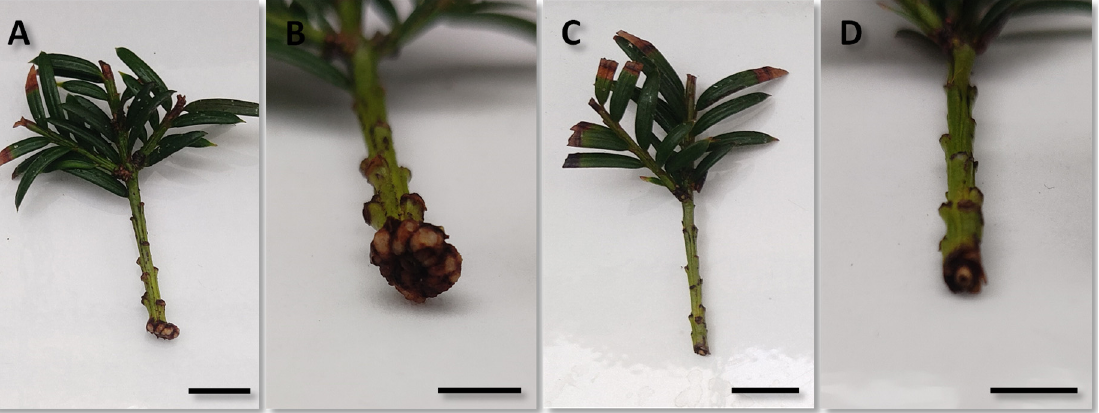
Figure 7. Ex vitro shoots inoculated by the dipping method after 2 months of inoculation. ( A ) Inoculated shoot. ( B ) Hard callus-like tissue on the inoculation site of the inoculated shoot. ( C ) Control shoot. ( D ) Inoculation site of the control shoot. Bars = 1.0 cm for ( A , C ), and bars = 0.5 cm for ( B , D ).